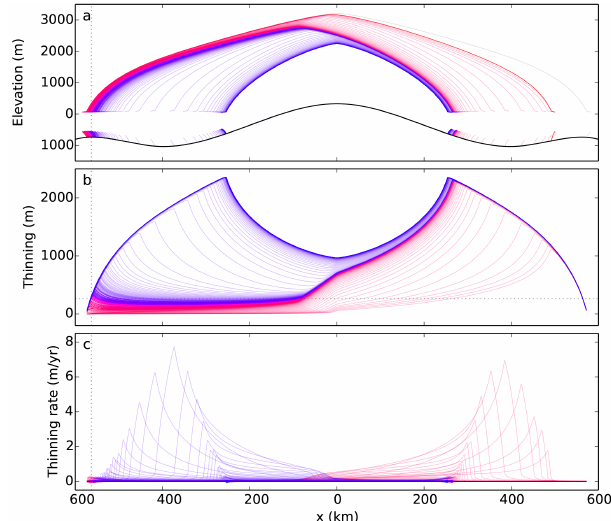
Figure 10. Ice-sheet (a) profile, (b) thinning with respect to the ice thickness at the end of perturbation and (c) thinning rate at multiple stages (time interval 100 years) of the unstable scenario U (simu- lation BC+330). The ice shelf is truncated for better visibility. The vertical dotted line indicates the location of maximum sill elevation x − s . The horizontal dotted line in panel (b) gives the amount of cu- mulative thinning necessary to cause the ice situated on the local bed maximum to become afloat. The same color-coding as in Fig. 4